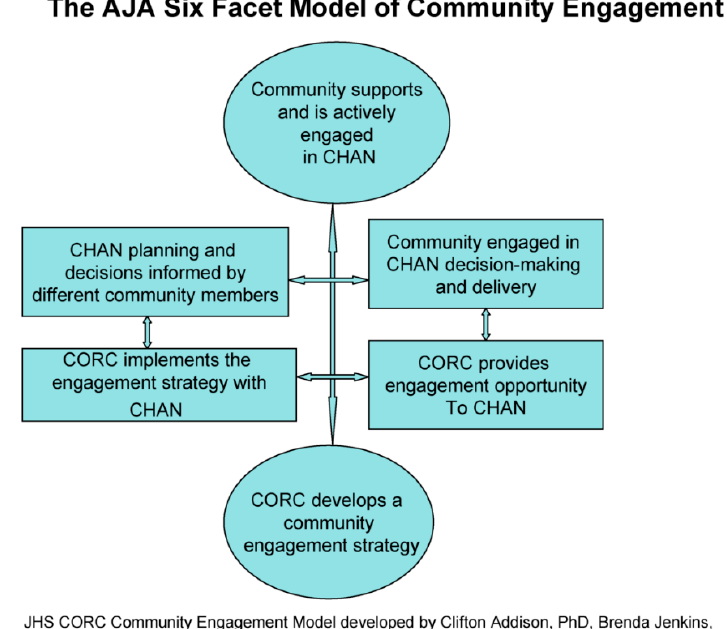
Figure 1. Community Engagement Model.